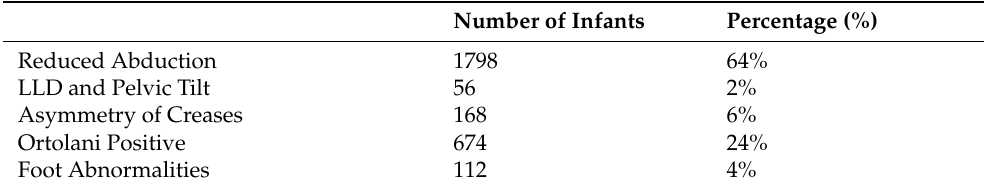
Table 2. Results of clinical examination of referred infants for DDH ( n =